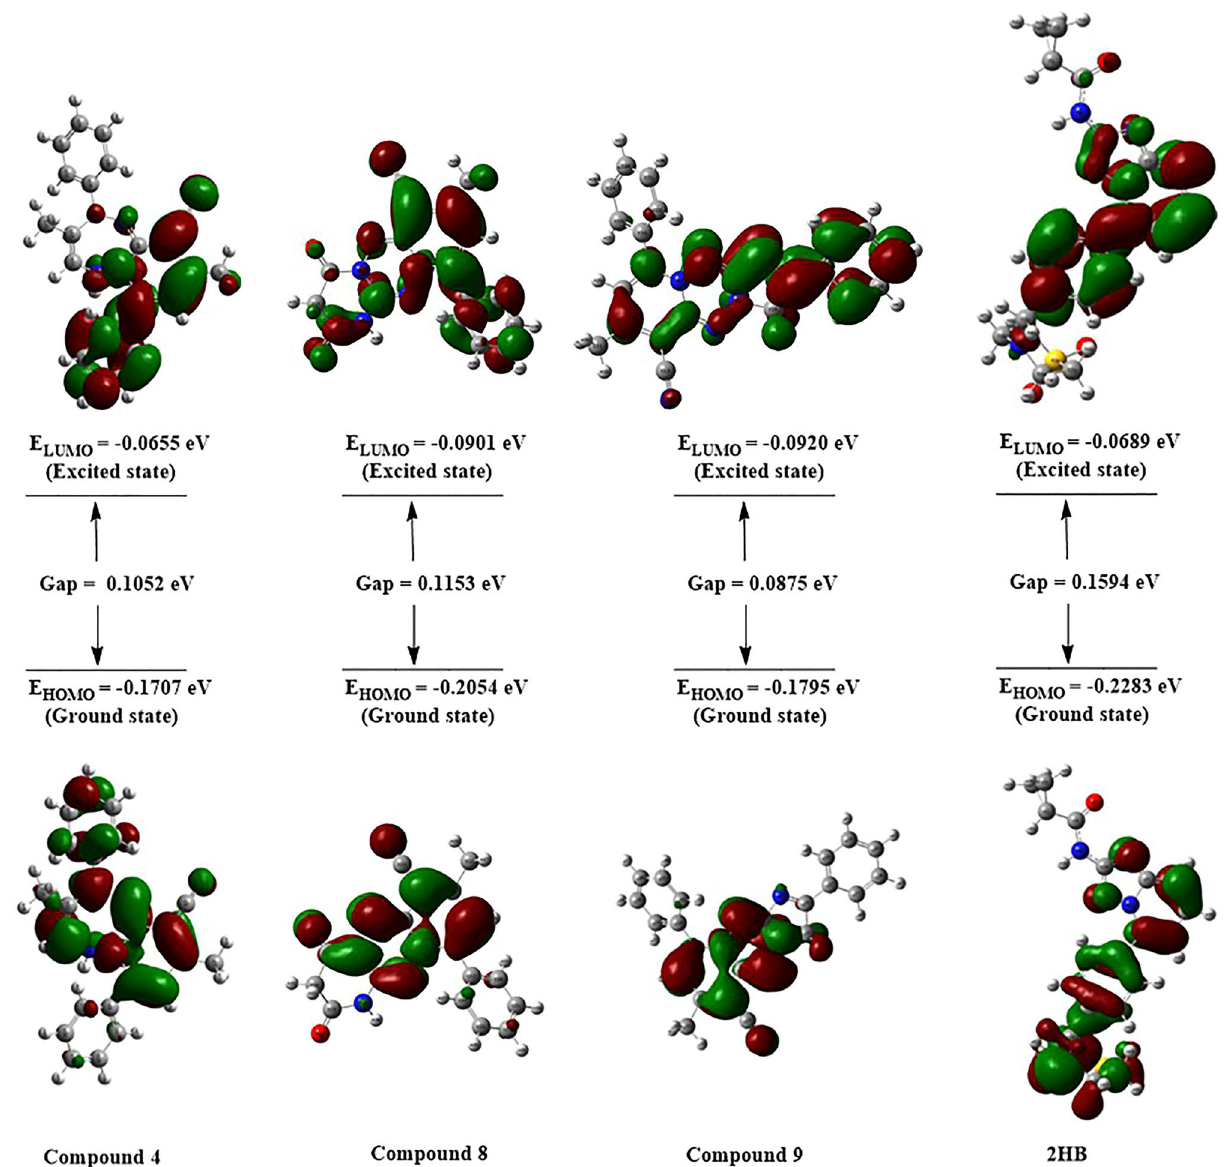
Figure 10. Molecular orbital distribution plots of HOMO and LUMO for compounds 4 , 8 , 9, and 2HB.